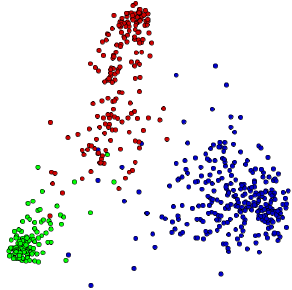
Figure 2. Example of a graphical representation created to show document similarities in 2D space. Each point represents a document, and each color represents the document